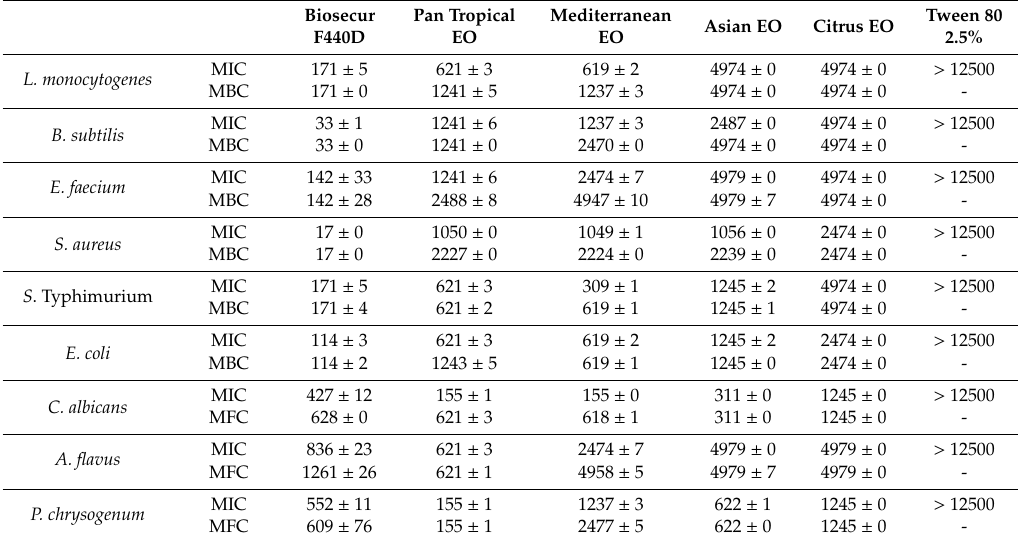
Table 3. Minimum inhibitory, bactericidal and fungicidal concentrations (MIC, MBC and MFC) of the selected antimicrobial